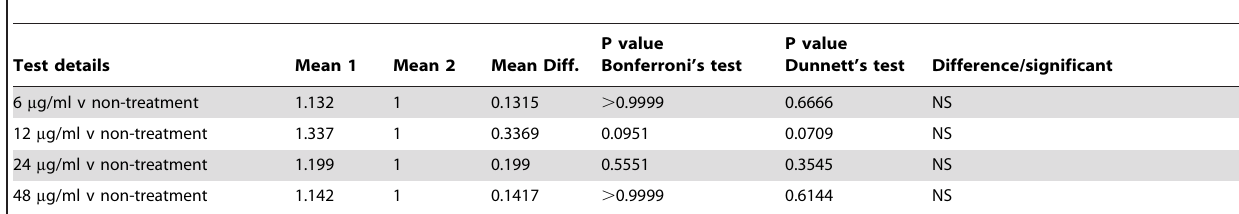
Table 2. Statistical comparisons (ANOVA) for PrP levels in flies treated with